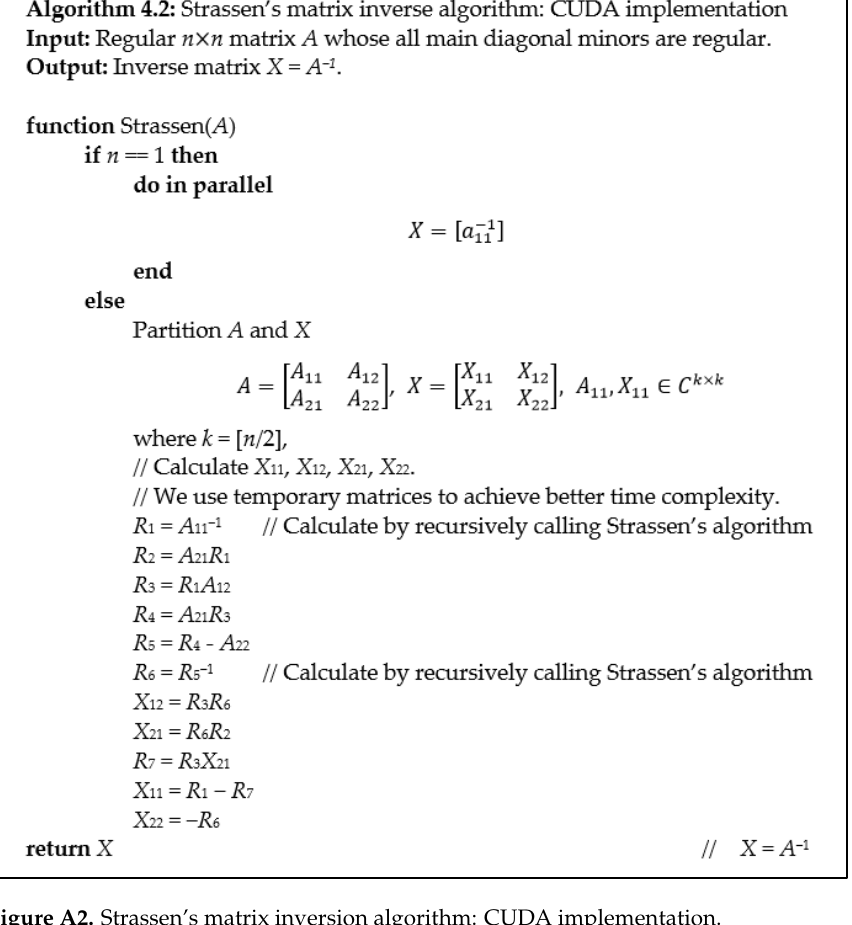
Figure A2. Strassen’s matrix inversion algorithm: CUDA implementation.